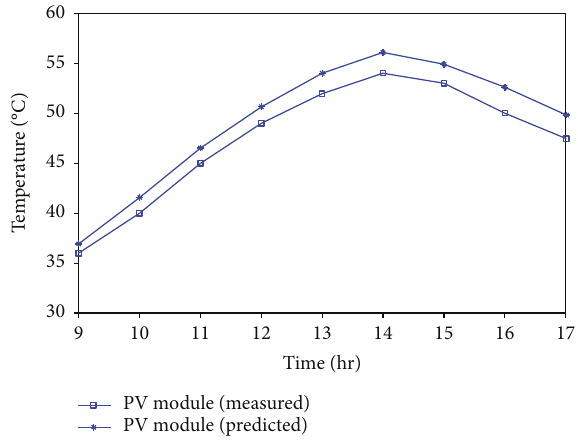
Figure 2: Comparison of measured and predicted PV